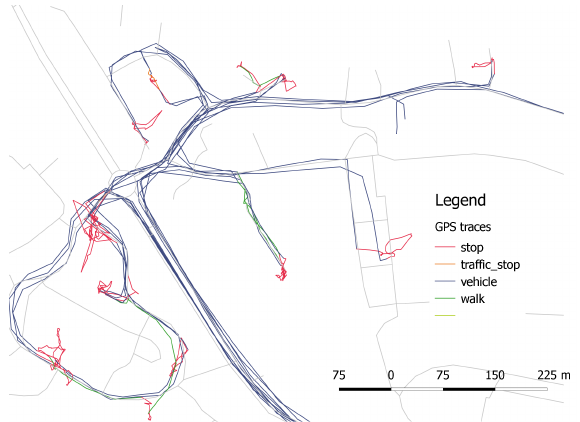
Figure 8: Classified GPS trajectories.